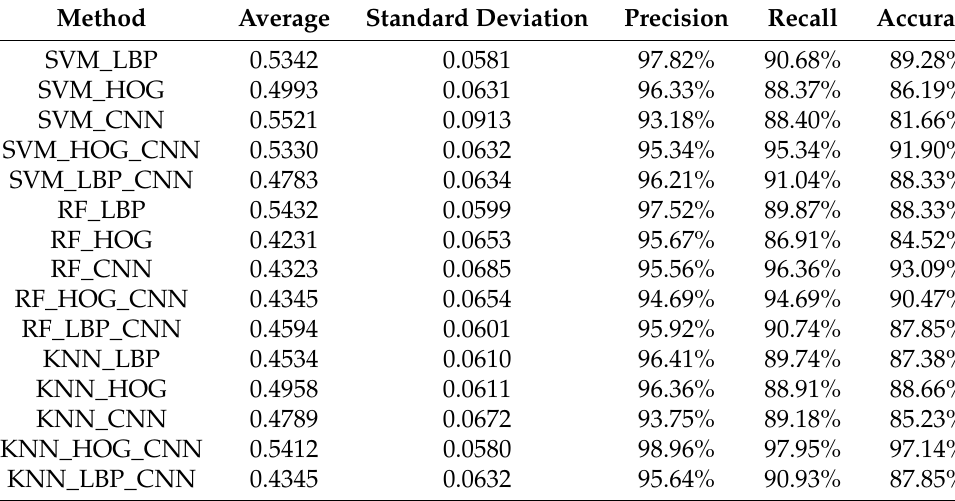
Table 8. Comparison of Different Proposed